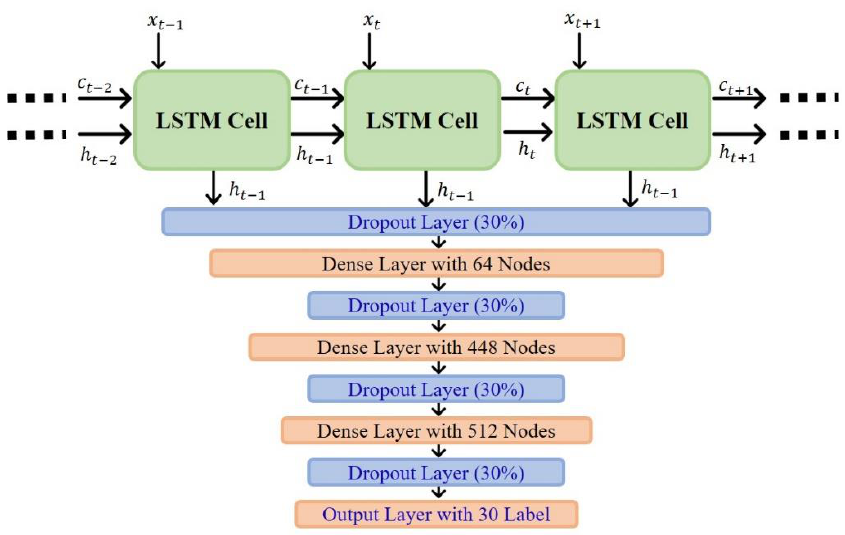
Figure 6. Established LSTM model structure with one LSTM layer and three dense layers.